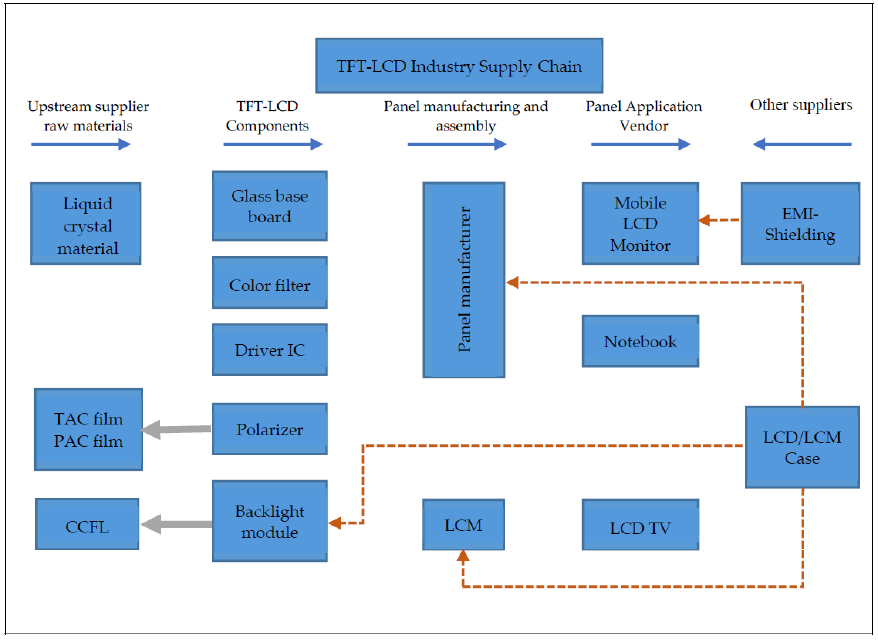
Figure 1. The Thin-Film Transistor Liquid-Crystal Displays (TFT-LCD) industry supply chain